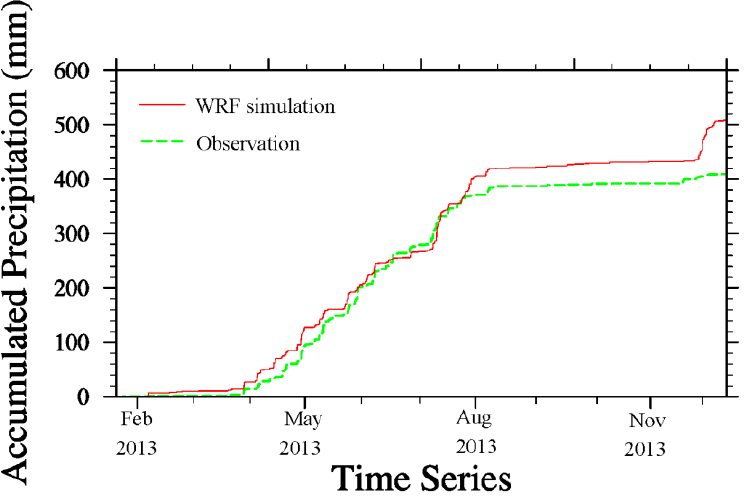
Figure 3. Comparison of time series of accumulated hourly precipitation between WRF simulation and observation at the AR HiWATER site in